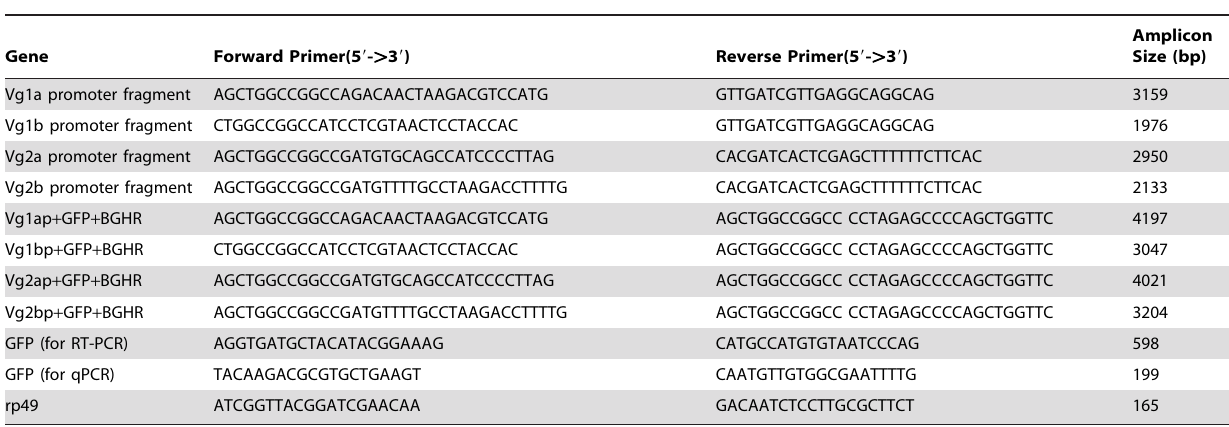
Table 1. PCR primers